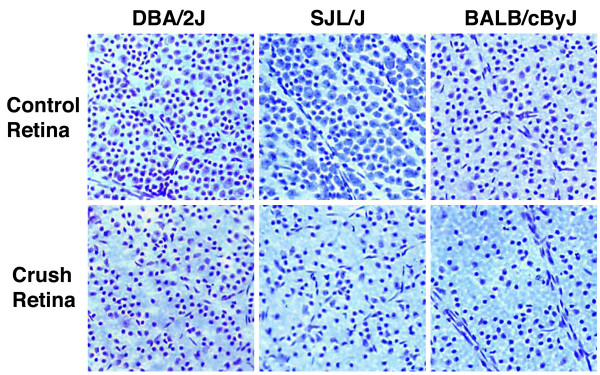
Nissl-stained ganglion cell layers from control and experimental eyes. Each panel is representative of the mid-central superior retina of the inbred lines shown. Two weeks after optic nerve crush, the retinas exhibit a loss of cells with larger somas and nuclei with prominent nucleoli, features characteristic of retinal ganglion cells. DBA/2J, SJL/J, and BALB/cByJ mice exhibit resistant, moderately resistant, and susceptible phenotypes to optic nerve crush, respectively. Magnification 200×.